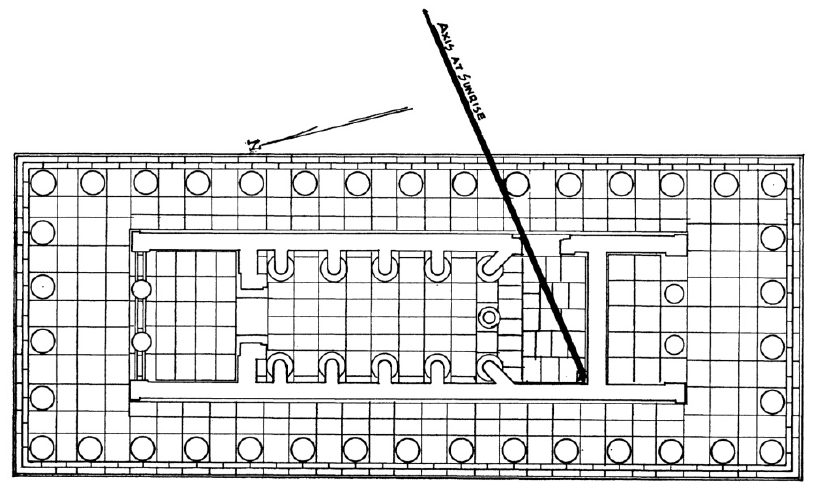
Figure 3. Cooper’s reconstruction of the angle of the light beam entering the adyton (after Copper, 1968, p.